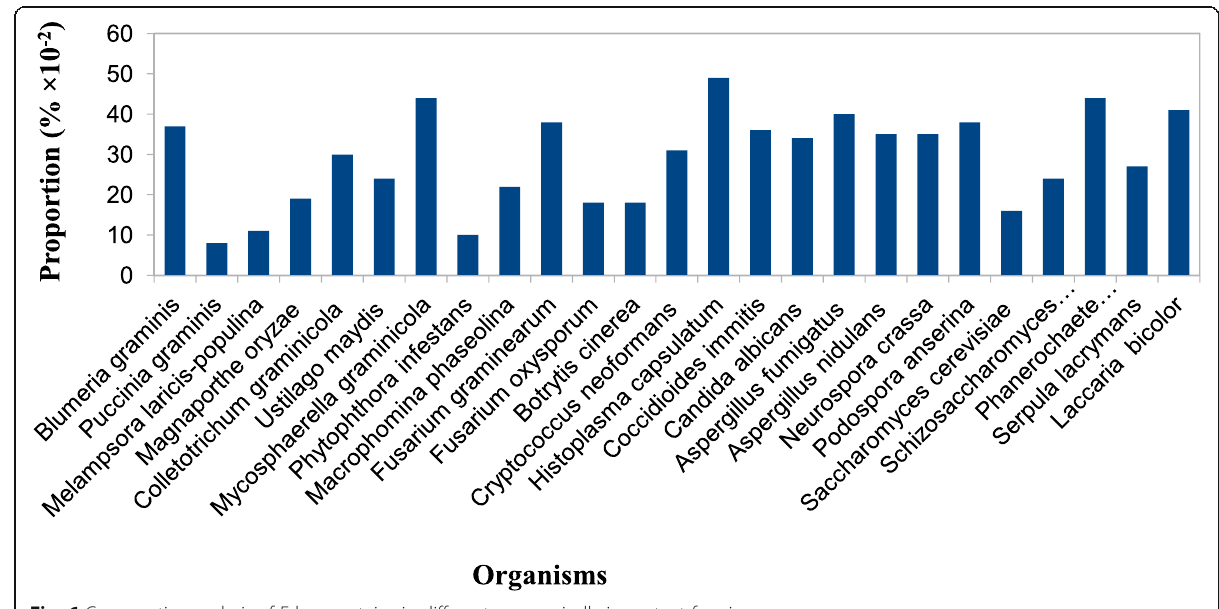
Fig. 6 Comparative analysis of F-box proteins in different economically important